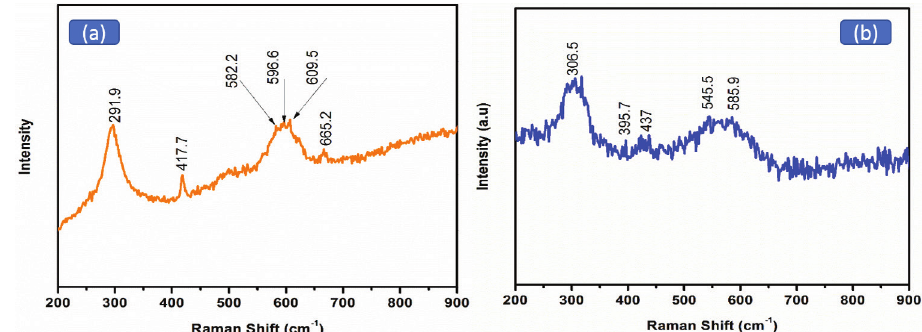
S and (b) Cd Zn S -ZnS composite thin films developed on FTO at 500°C via AACVD technique. 2 4 7.23 2.77 10